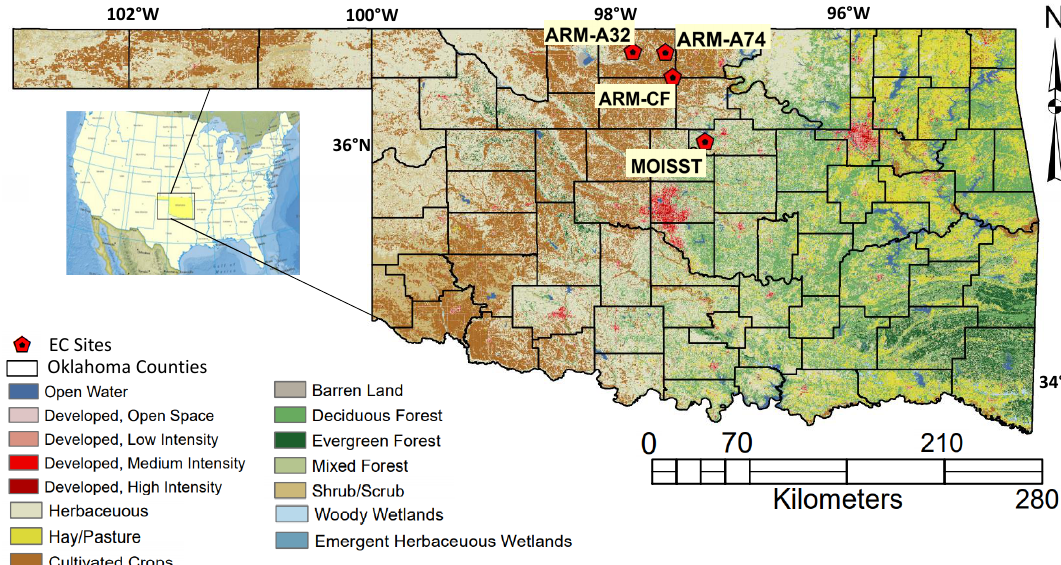
Figure 1. Location of the four eddy covariance (EC) sites adopted in this study: U.S. Department of Energy Atmospheric Radiation Measurement Program Southern Great Plains Central Facility site (ARM-CF) (cropland) in Marena, Oklahoma, and In Situ Sensor Testbed site (MOISST) (grassland), ARM SGP US-A74 (cropland), and ARM SGP US-A32 (grassland) in north central Oklahoma, USA. Land cover types according to the National Land Cover Dataset (NLCD 2016) within Oklahoma are also